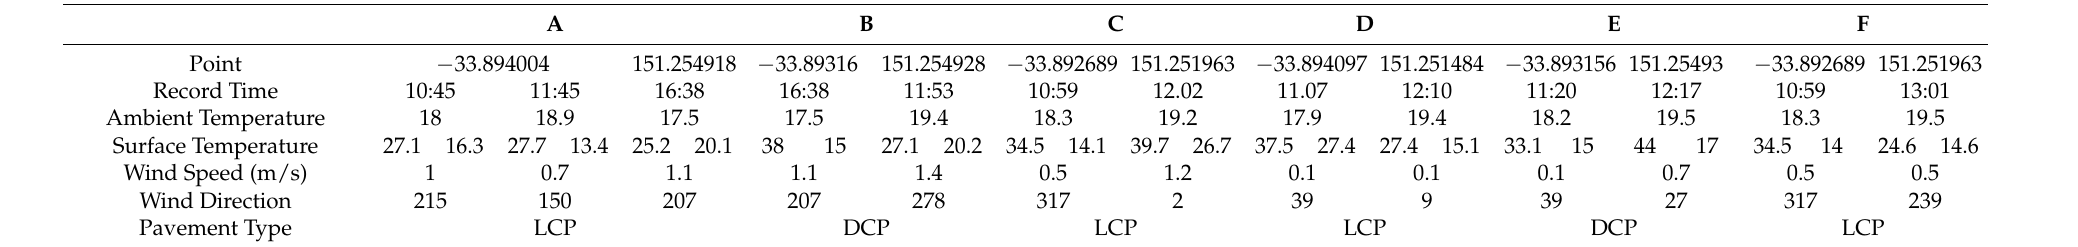
Table 2. Measured variables during the fieldwork